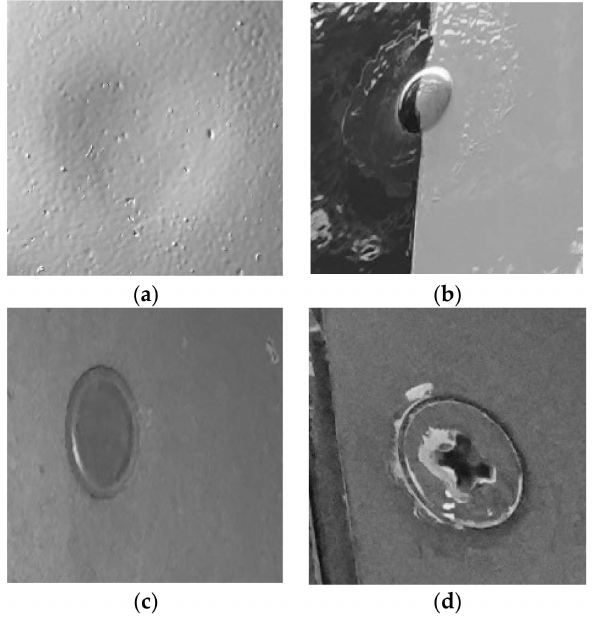
Figure 2. Sample images from the two datasets created for training the classifiers. ( a ) An image of a dent, ( b ) a lighting strike fastener repair; ( c , d ) are images with objects that are not defects.